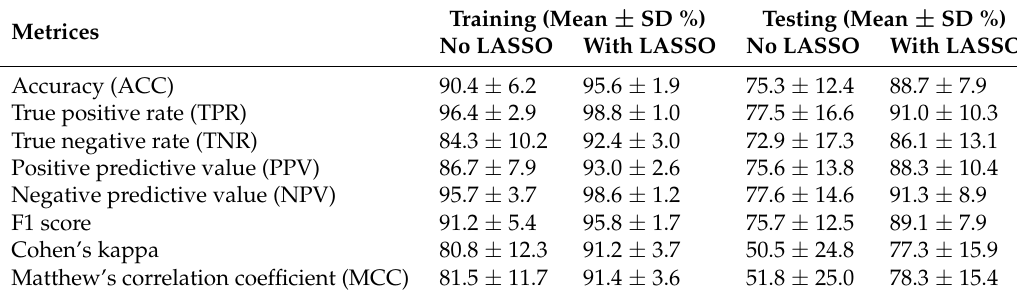
Table 8. Phase 2: Supervised machine learning result—SVM with RBF kernel.